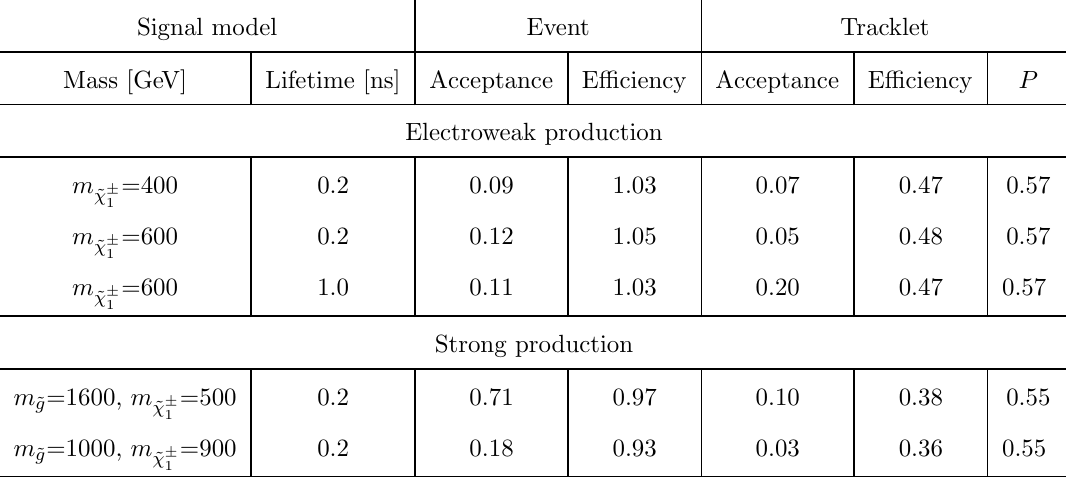
Table 2 . The event and tracklet generator-level acceptance and selection e(cid:14)ciency for a few signal models studied in this search. The last column shows the probability ( P ) for a reconstructed tracklet to have p T greater than 100 GeV. For details, see